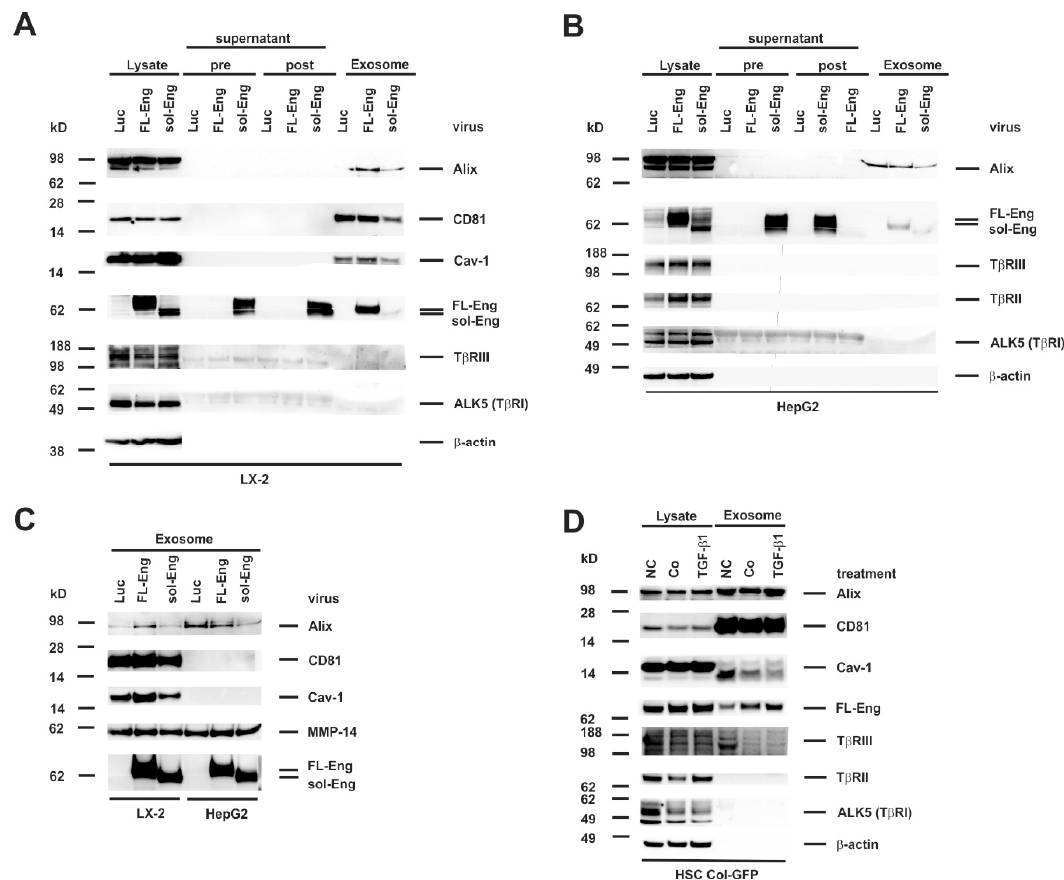
Figure 5. Identification of full-length Endoglin and soluble Endoglin in liver cell lines. ( A , B ) Cell protein extracts, supernatant (pre), wash solution (post), and final exosome preparations from ( A ) LX-2 or ( B ) HepG2 infected with adenoviral constructs expressing luciferase (Luc), full-length endoglin (FL-Eng), or soluble endoglin (sol-Eng) were analysed by Western blot for expression of indicated proteins. ( C ) Direct comparison of proteins included in exosomes purified from cultured LX-2 and HepG2 cells which were infected with adenoviral expression vectors driving expression of Luc, FL-Eng, and sol-Eng. ( D ) Cell lysates and corresponding exosomes fractions from HSC Col-GFP were analyzed in parallel in Western blot analysis. Exosomal markers and TGF- β -receptors were detected with specific antibodies. To monitor equal protein loading, the membrane was re-probed with a β -actin specific antibody. Please note, that only Endoglin and no other TGF- β -receptors analyzed were detected in significant amounts in exosomes. Abbreviations used are: NC, normal control meaning untreated cells cultured in the presence of normal growth medium containing 10% FCS; Co / TGF- β 1, cells that were starved overnight (~16 h) in medium containing 0.5% FCS before stimulation with TGF- β 1 (1.0 ng / mL) (TGF- β 1) or not (Co) for 24